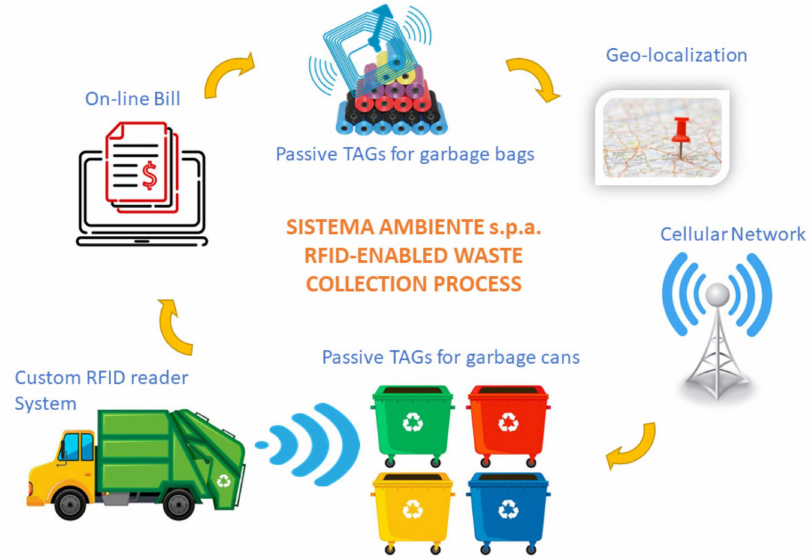
Figure 1. The waste collection cycle carried out by Sistema Ambiente s.p.a. company in Lucca,